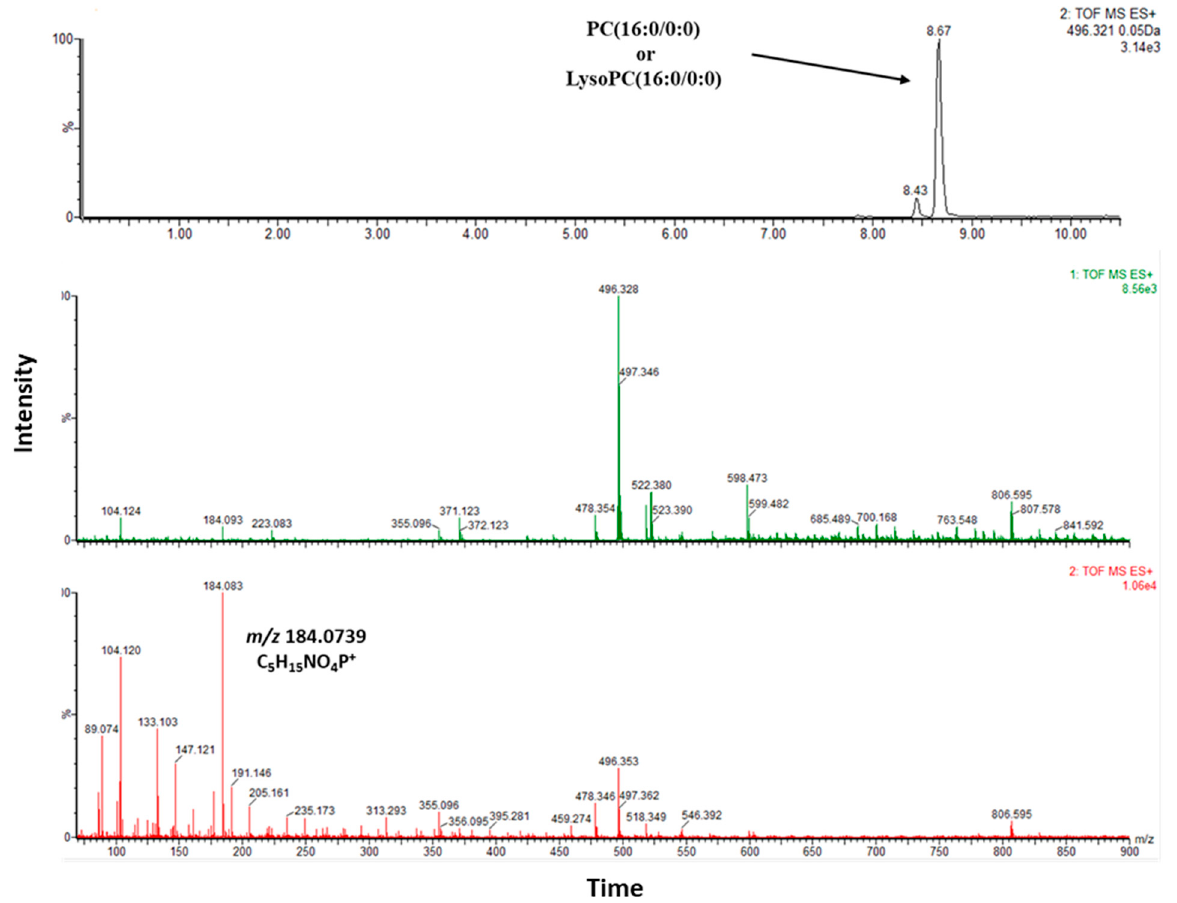
Figure 5. Chromatographic peak of phosphatidylcholine (16:0/0:0) or lysophosphatidylcholine (16:0/0:0) along with MS and MS/MS spectra.